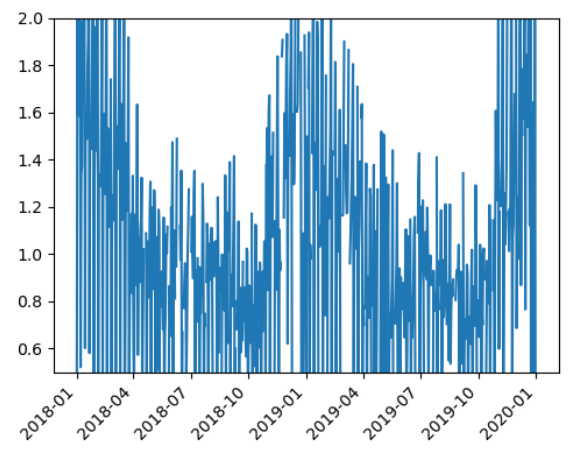
Figure 10. Aggregated occupancy ratio R agg between 2018-01-01 and 2019-12-31, estimated with the C/DiffT method. A value of 1.0 means that the occupancy ratio was about the same as a median day. A value of 2.0 means it was double than a median